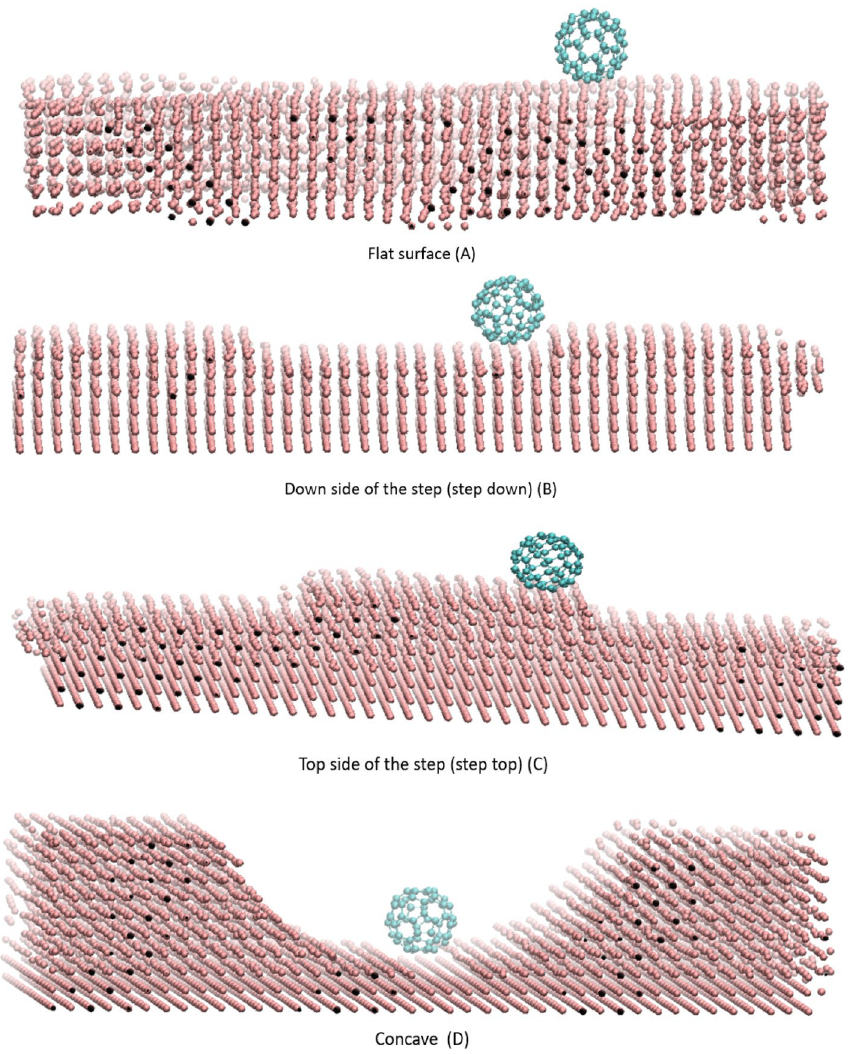
Figure 2. C 60 fullerene on different gold substrates. ( A , B , C , and D ) representing the Flat surface, Down side of step, Top side of the step, and Concave substrates,